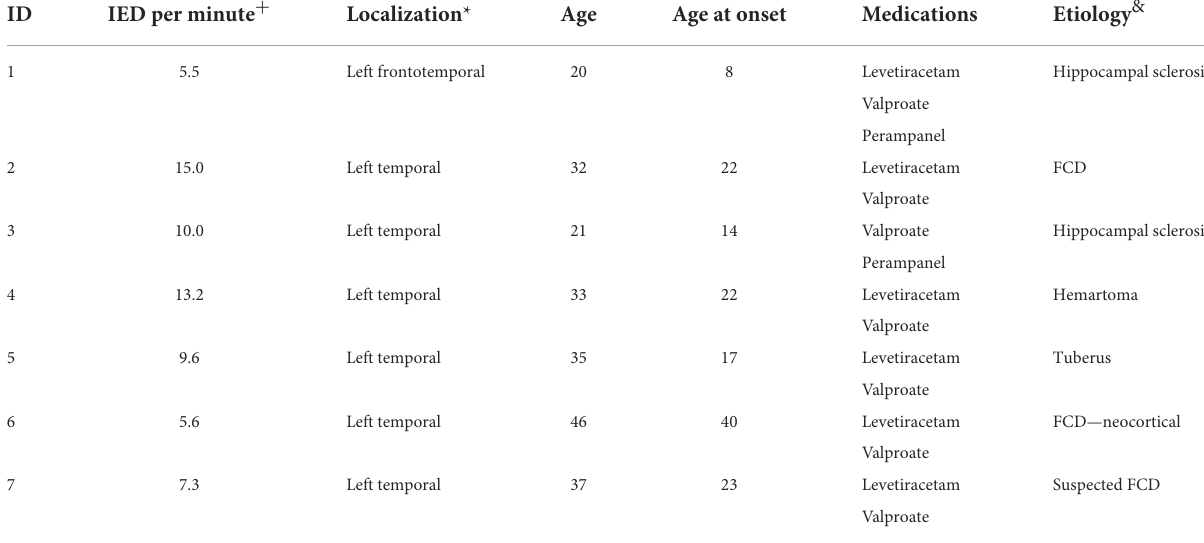
TABLE 1 Clinical and demographic description of the included